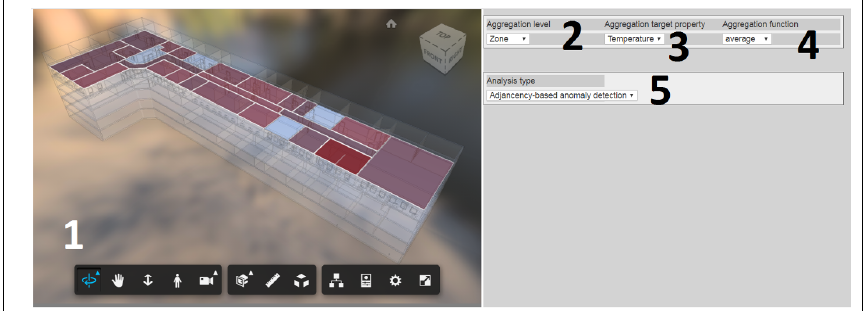
Figure 3: Model structure in the Autodesk